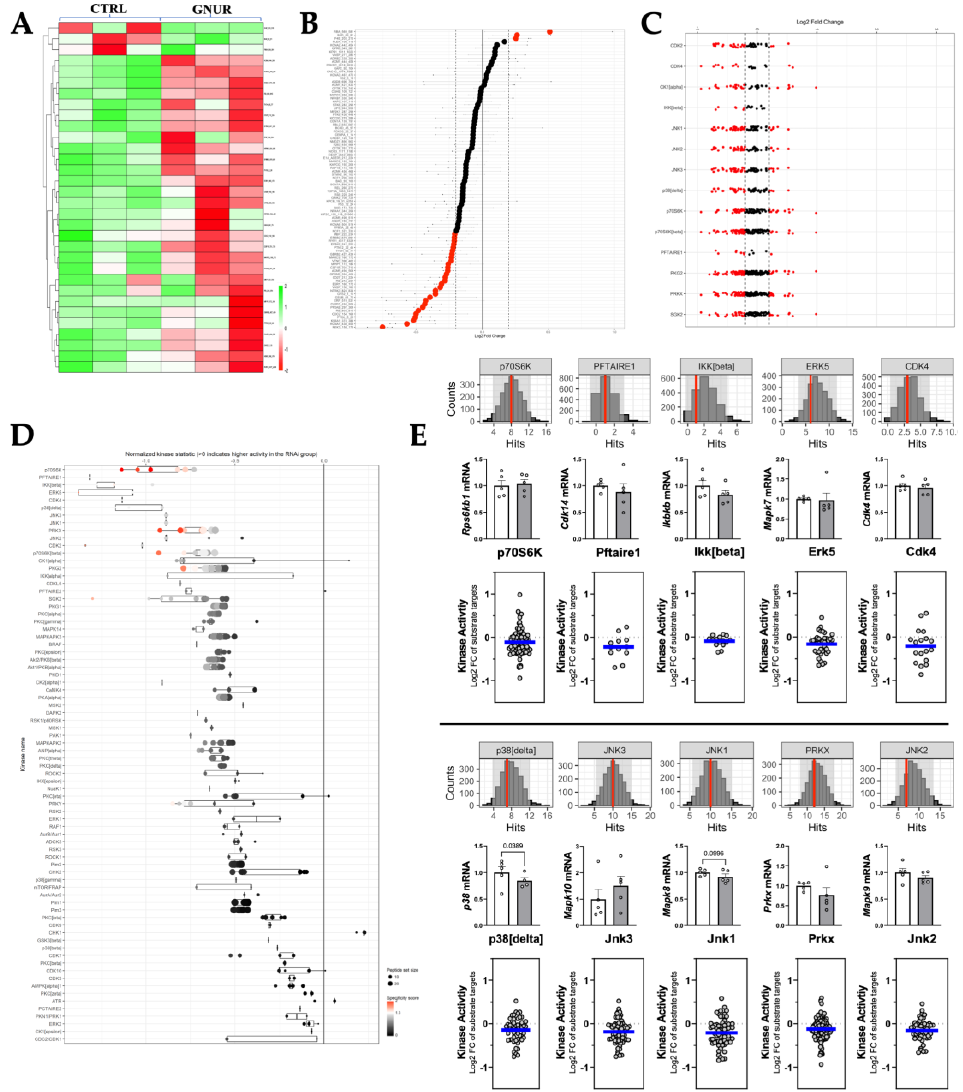
Figure 6. Serine/threonine kinase (STK) PamGene kinome activity analysis. ( A ) Heatmap analysis of differential STK substrate phosphorylation. ( B ) Waterfall plots are shown by log fold change of substrate phosphorylation. ( C ) Differentially phosphorylated substrates mapped back to responsible kinases (upstream analysis) by reverse KRSA analysis. ( D ) Waterfall plot of individual kinases. ( E ) Peacock plots (confidence measure indicated by red line), mRNA measurements, and MEOW plots for the top kinases.